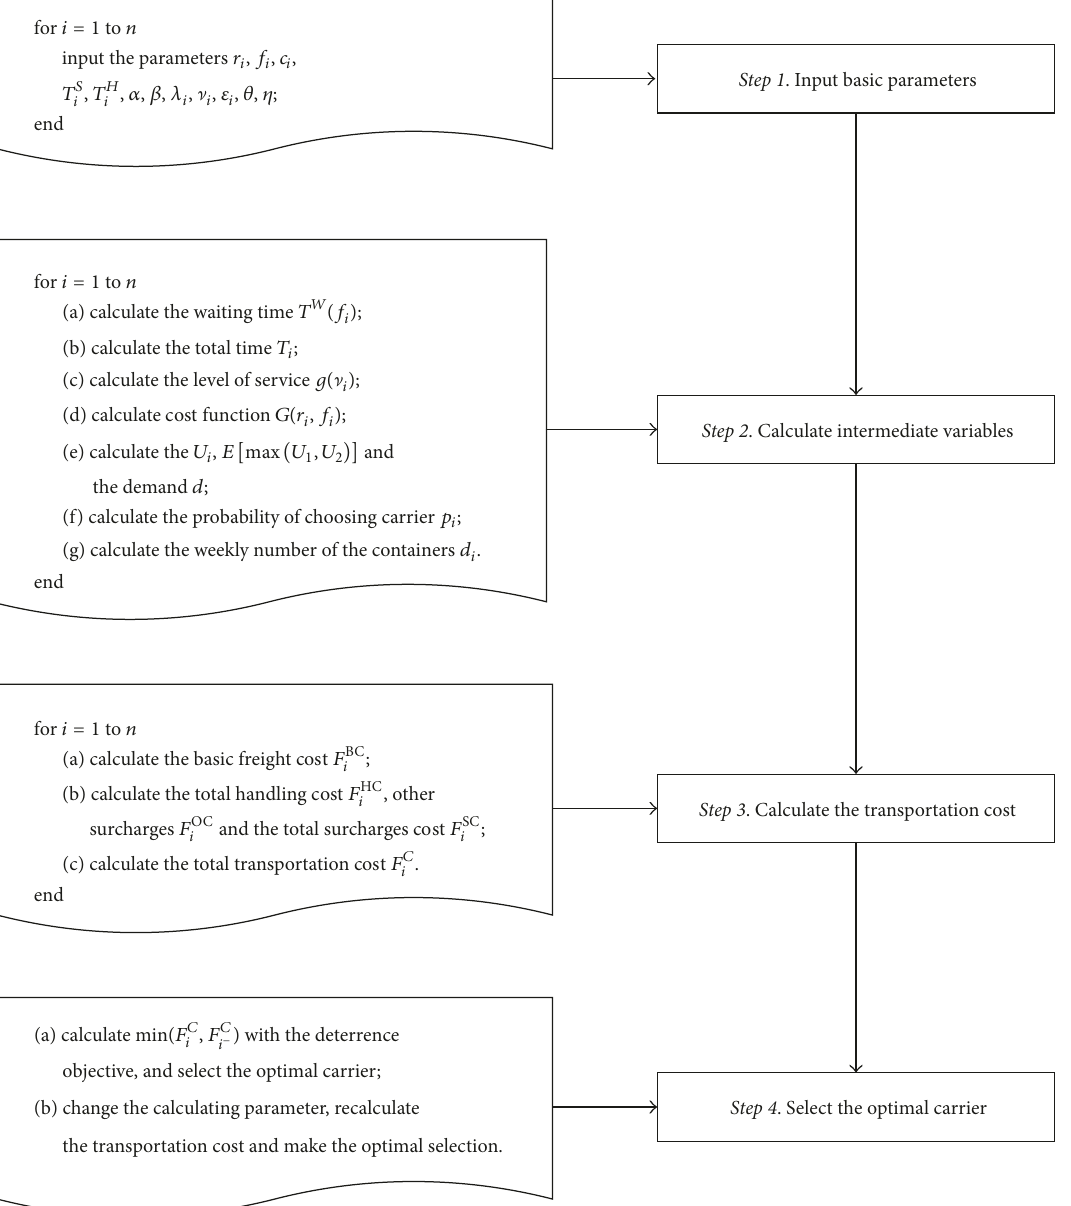
Figure 3: The algorithm of deterrence